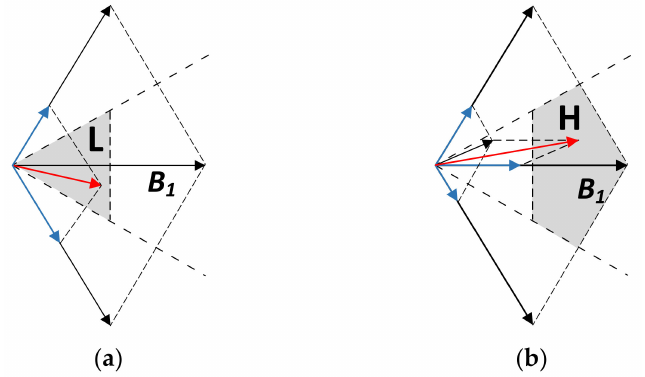
Figure 3. Vector constructing method of TSPWM: ( a ) low region; ( b ) high region. The CMV of SVWPM and TSPWM in different regions are compared in Figure 4.